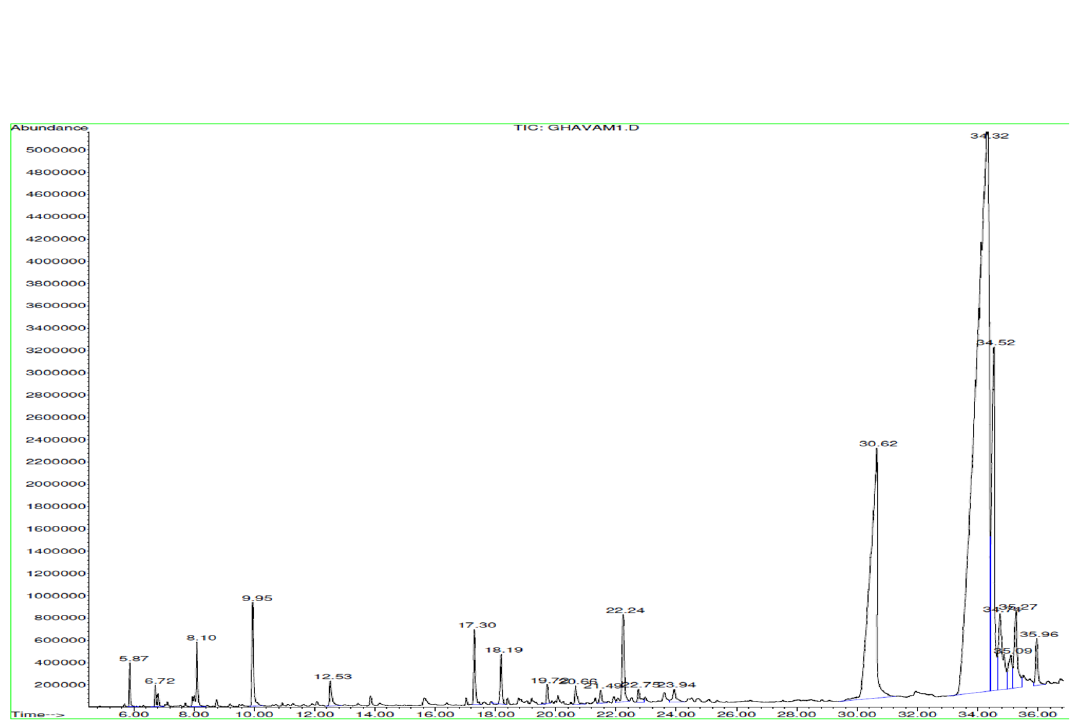
Figure 2. GC–MS chromatogram of essential oil obtained from Nepeta